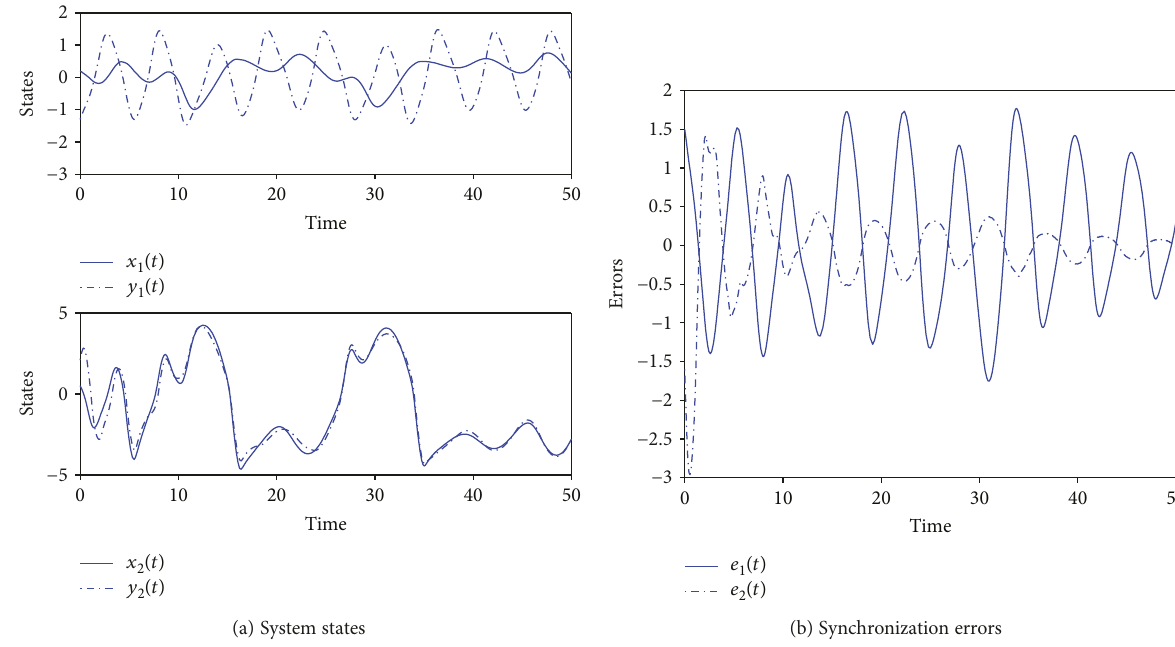
Figure 5: The temporal evolution of each variable and the plot of synchronization errors driven only by the signal x cannot be achieved in Example